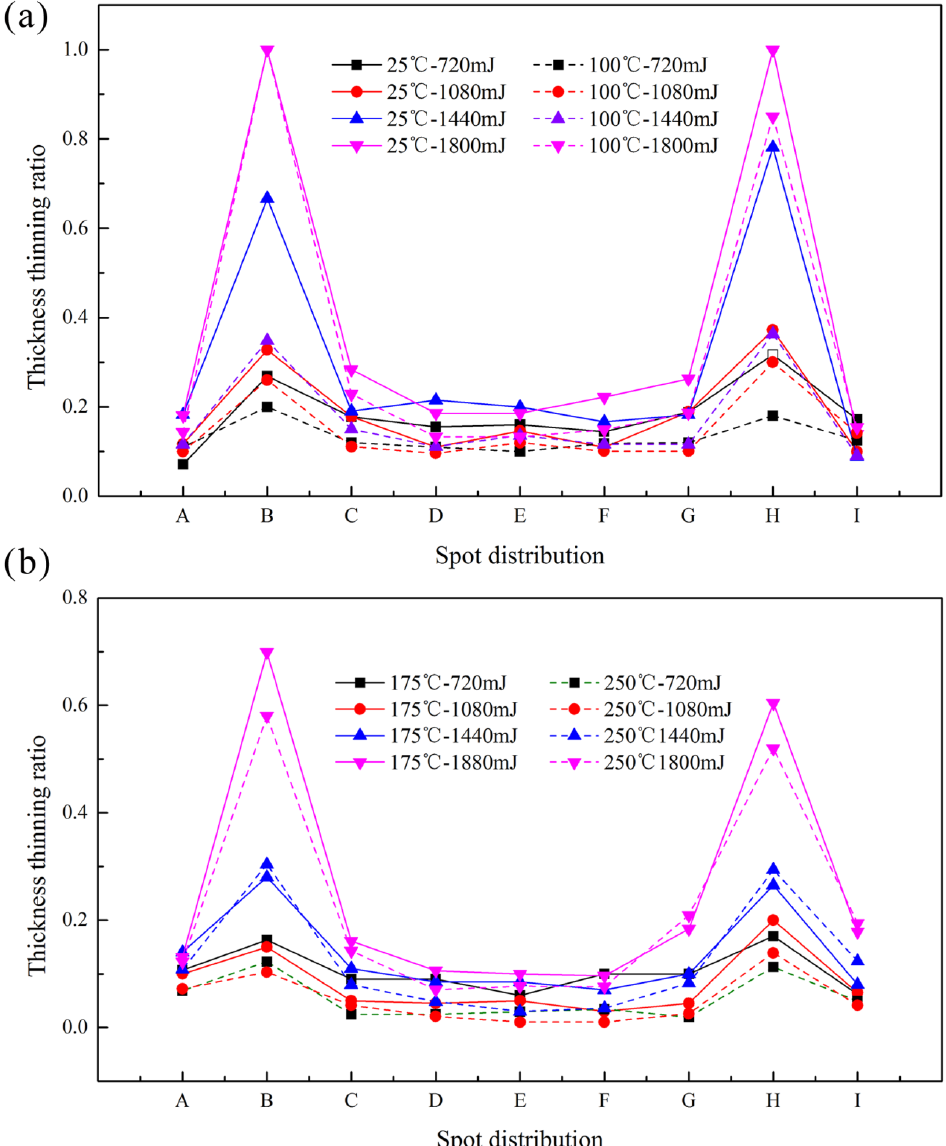
Figure 10. The distribution of thickness thinning ratio with different laser energy and temperature: